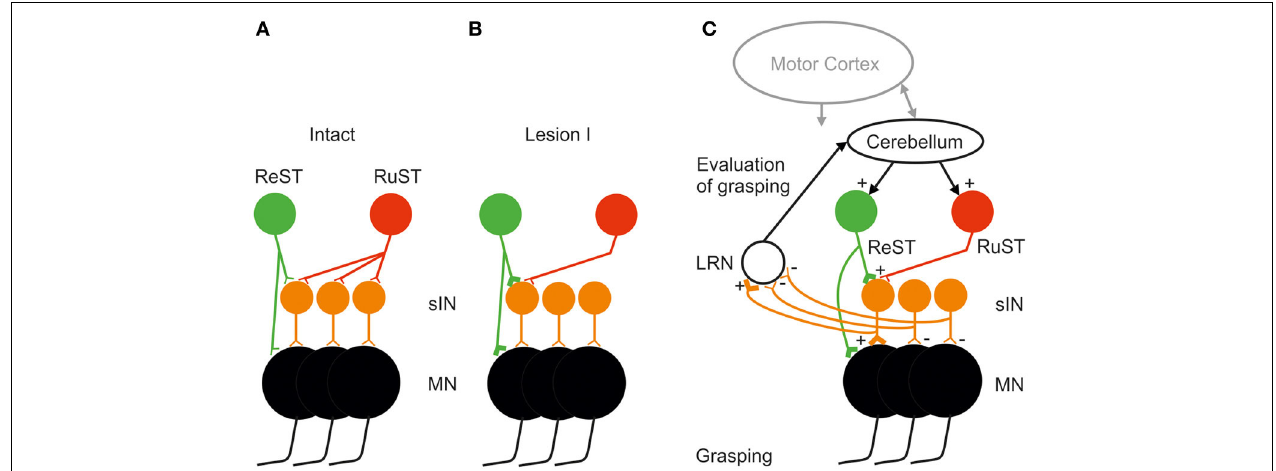
FIGURE 4 | Tentative explanation of facilitated takeover of digit grasping by the ReST after an incomplete DLF lesion sparing only a small fraction of the RuST (as illustrated in Figures 2B,E). (A) Before lesion, the illustrated group if sINS used for digit grasping all receive input from the RuST whereas only a minority of them from the ReST. (B) After the DLF lesion, the remaining synapses from the RuST (active during attempted digit-grasping) are assumed, by a mechanism of